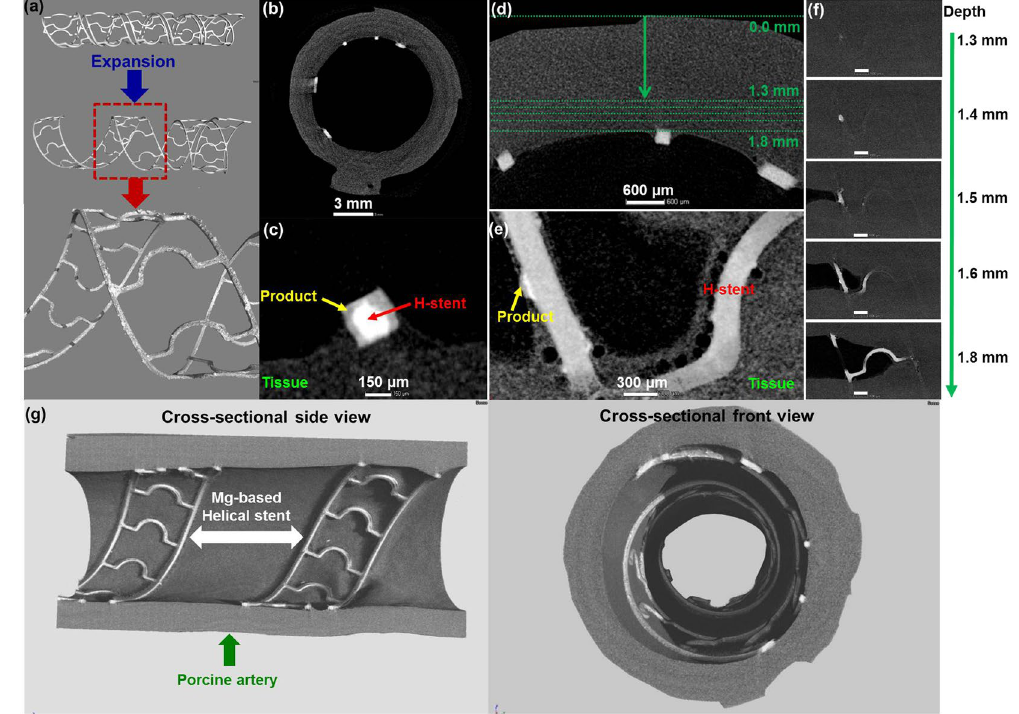
Figure 6. 3D structure and cross-sectional 2D micro-CT images of expended helical stents in artery revealing the with corrosion products ex vivo dynamic simulation for 3 days in DMEM (10% FBS, 1% P/S) at 37 °C, 5% CO 2 . ( a ) Bare stent and extracted stent in artery, ( b ) 2D sliced image, ( c ) Enlarged one strut of ( b ), ( d ) Interface between implanted helical stent and tissue, ( e ) Enlarged images at a depth of 1.6 mm in ( d , f ) sliced images from outmost of artery to lumen (arrow direction in ( d )), ( g ) Actual representative X-ray micro-CT 3D structures of expanded Mg-based helical stent scaffold at the porcine artery. Product: Ca/P complex, H-stent: Mg helical stent, Scale bars on ( f ): 1 mm.